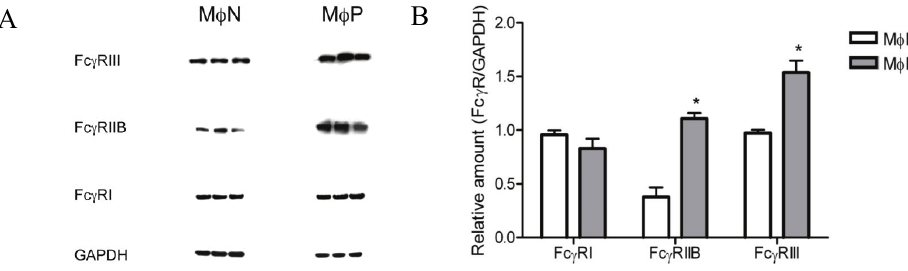
Figure 6. Total Fc γ RI, RIIB, and RIII protein in M φ N and M φ P cell extracts. ( A ) Cells from three different passages of M φ N and cells from passages 72, 83 and 87 of M φ P were lysed and Fc γ RI, Fc γ RIIB, Fc γ RIII and GAPDH proteins in cell extracts were determined by Western blot with specific antibodies; ( B ) The relative amount of each Fc γ R isoform was determined as the ratio of the densitometric intensity of the Fc γ R band to the intensity of the GAPDH band in the correspondent cell extract. Results are expressed as mean ± 1 SD (* indicates p <